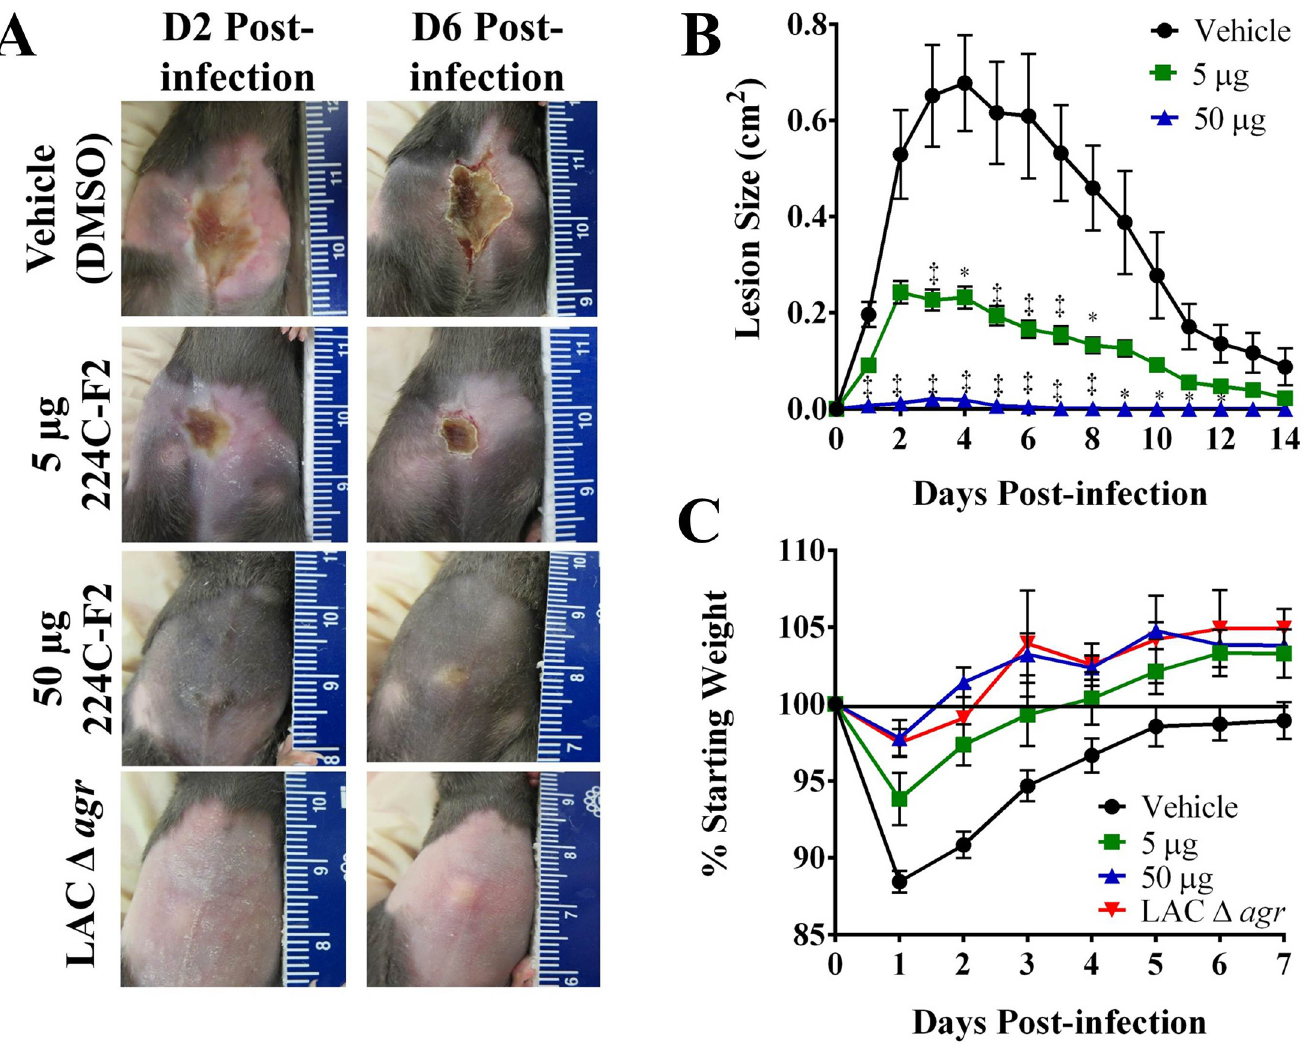
Fig 8. 224C-F2 attenuates MRSA-induced dermatopathology in a murine model of skin and soft tissue infection. C5Bl/6 mice were intradermally injected with 1x10 8 CFUs of LAC (USA 300 isolate, AH1263) or its agr deletion mutant (AH1292). Mice received a single dose of 224C-F2 (at 5 or 50 μ g) or the vehicle control (DMSO) at the time of infection. Significant differences between treatment and vehicle are represented as: * : p < 0.05; ‡ : p < 0.01. (A) Images of abscesses and ulcers on days 2 and 6 post-infection (scale in cm). (B) 224C-F2 attenuates dermatopathology with a single dose of either 5 or 50 μ g. (C) 224C-F2 reduces morbidity and mice do not lose